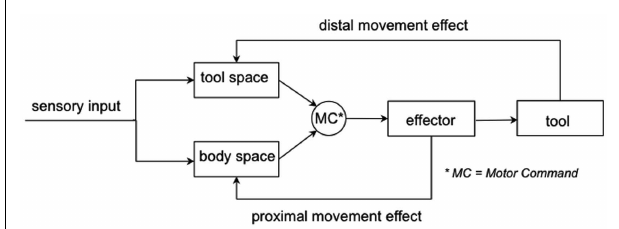
FIGURE 1 |The dual action-feedback loop of goal-oriented actions when using a tool. The motor commands launch at first a movement of the body effector, which then causes the desired displacement of the tool. Thereby the actor receives the movement feedback from the own body (proximal movement effect) and from the tool (distal movement